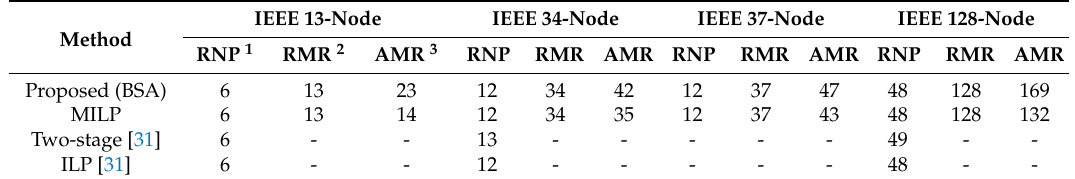
Table 3. Comparison of optimal numbers of PMU without considering ZIB and channel limits.